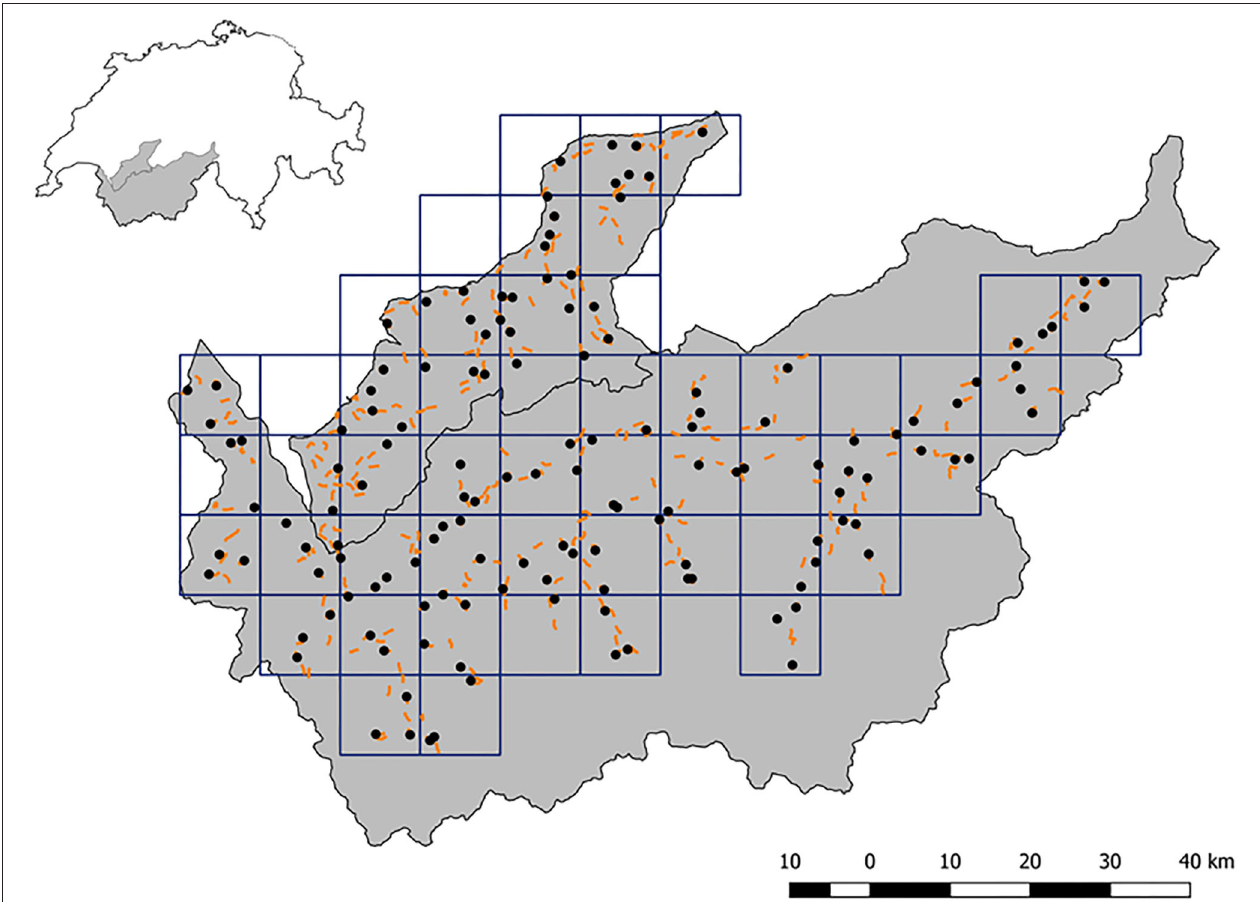
FIGURE 2 | The study areas in the Prealps (upper perimeter) and Valais (lower perimeter; see Figure 1 ) and their location within Switzerland (upper left inset). The grid (10 × 10km) indicates the raster used for sampling stratification and orange lines show the 313 1-km long transects along which snowtracking of wild ungulates was performed. The black dots depict camera-trap